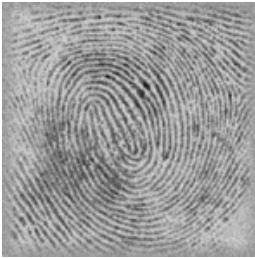
Figure 7. Secret image Finger (148 × 148).